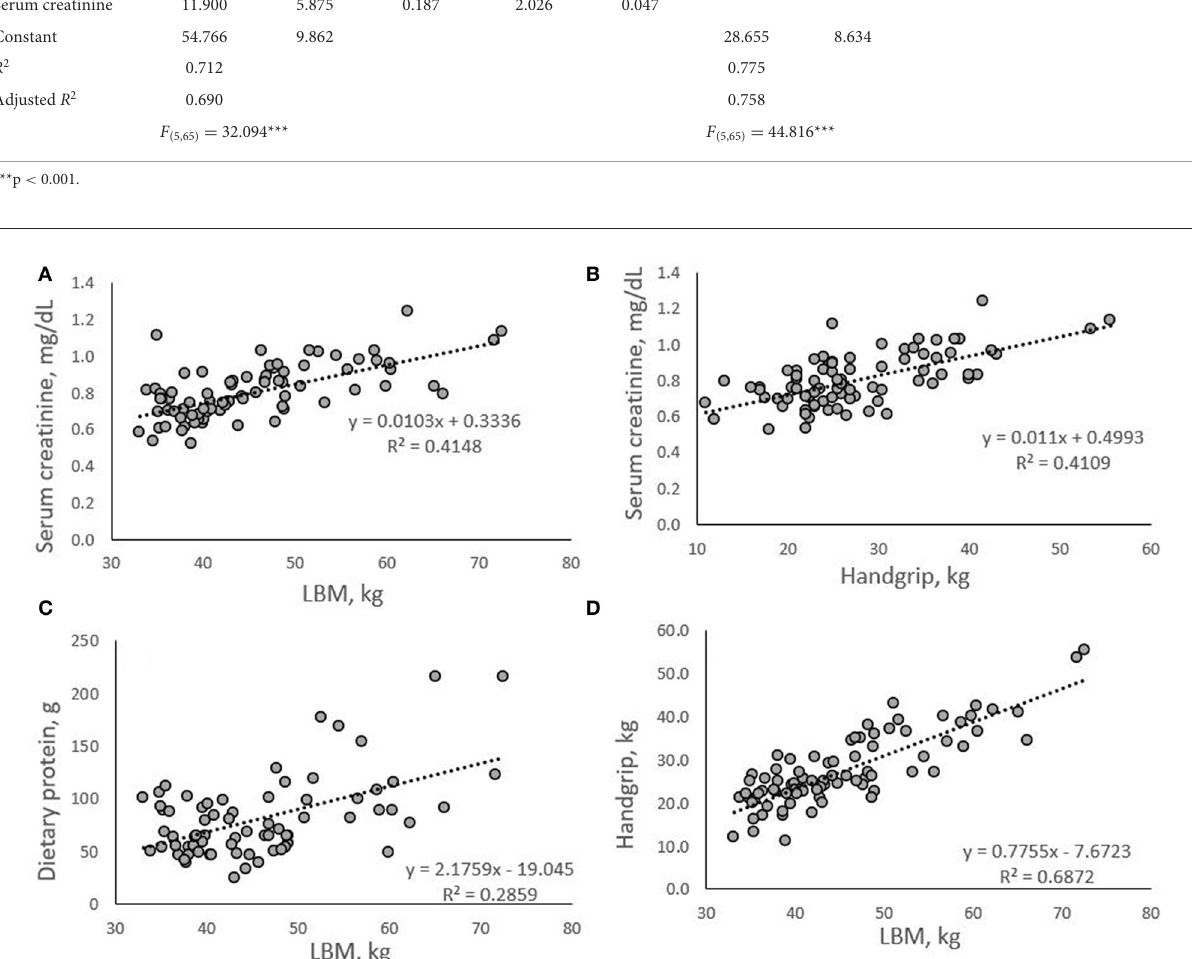
mEq/L. The vegetarian men and women averaged